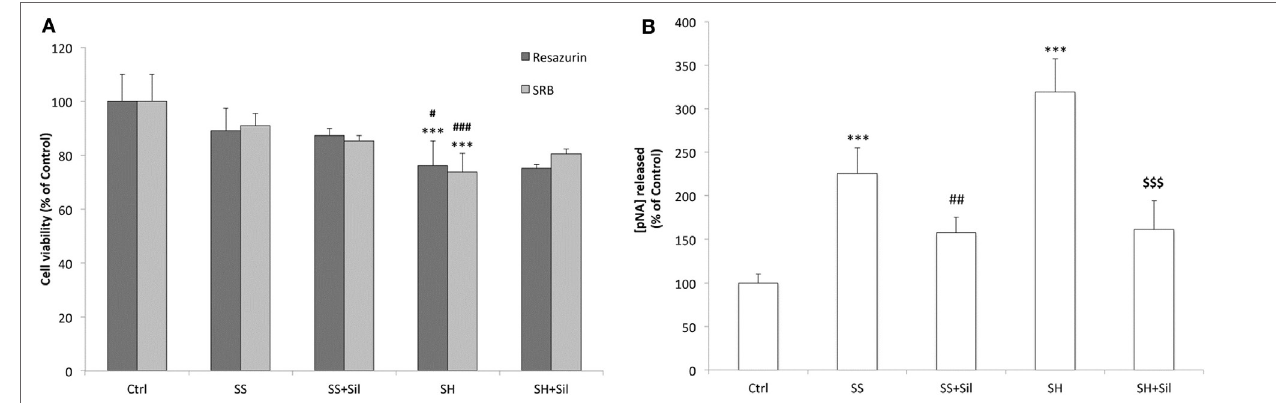
FigUre 3 | Effect of silybin on cell proliferation and apoptosis. Under the conditions of Figure 1 , the following parameters were measured: (a) The metabolic activity and the cell mass by resazurin and sulforhodamine B (SRB) assay, respectively. Data are expressed as percentage values with respect to controls. (b) The activity of effector caspase 3, measured as p-nitroanilide (pNA) released after cleavage from the substrate (nmoles of pNA released/ μ g protein). Calibration was done using known concentrations of pNA. Values are mean ± SD from at least three independent experiments. ANOVA followed by Tukey’s test was used to assess the statistical significance between groups. Significant differences are denoted by symbols: Ctrl vs all treatments *** p ≤ 0.001; simple steatosis (SS) vs all treatments ### p ≤ 0.001, ## p ≤ 0.01, # p ≤ 0.05; steatohepatitis (SH) vs all treatments $$$ p ≤